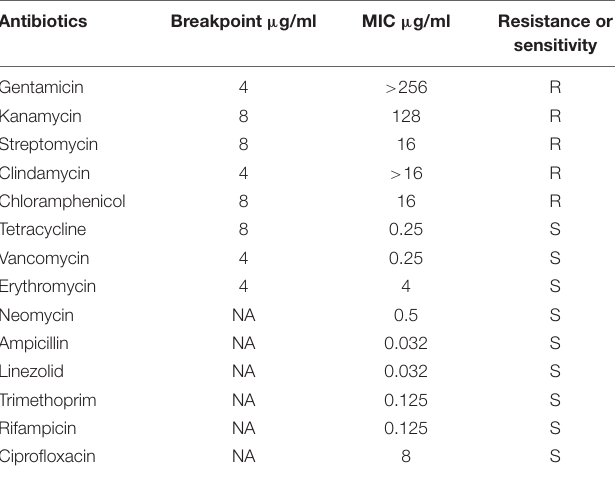
TABLE 1 | Antibiotic resistance profiles of C. tyrobutyricum L319.